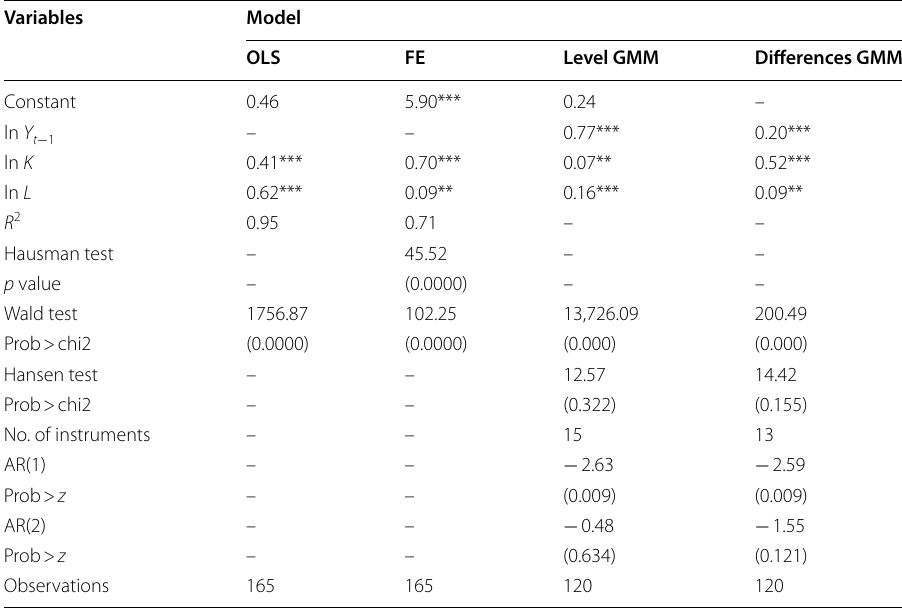
Table 2 Estimates in the regions, 2004–2014 Source: own elaboration based on data from IBGE, PNAD, and BEA